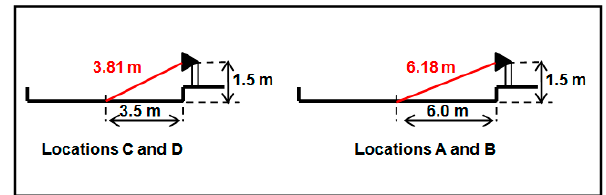
Figure 1. Survey locations.